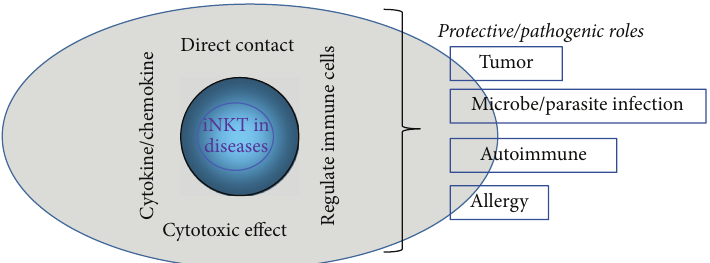
Figure 1: Diagram of iNKT cells in diseases. Activated iNKT cells can secrete a broad range of Th1, Th2, and Th17 effector cytokines and change the cytokine profiles of hosts in vivo. iNKT cells can directly bind target cells, such as autoreactive B cells and pathogens, to mediate cytotoxic activity. Moreover, iNKT cells may cross talk and regulate different T cell subsets. Through these and other mechanisms, iNKT cells exert, in most cases, protective, or otherwise, pathogenic roles in the pathogenesis of various diseases.